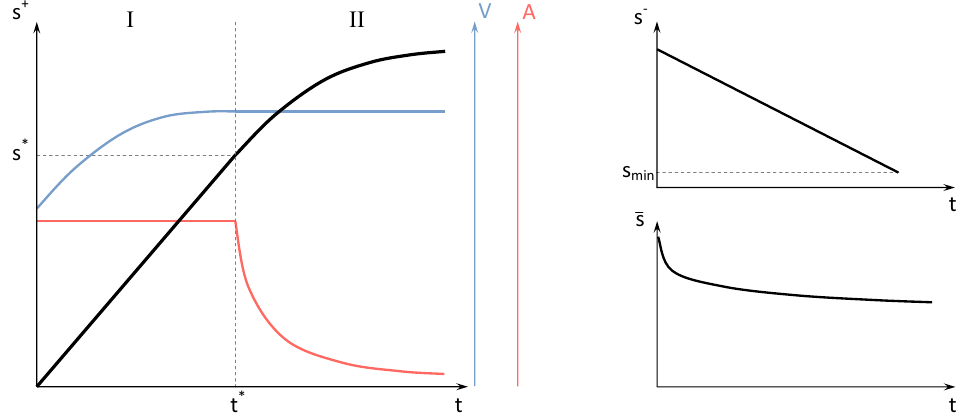
Figure 1. Schematic illustration of the charging and discharging behaviour of a lithium-ion battery. ( left ) Two-stage charging process plotted over time t . State of capacity s + in black, voltage V in blue, and current A in red. ( top right ) State of capacity s − during discharging over time t . ( bottom right ) State of capacity ¯ s due to